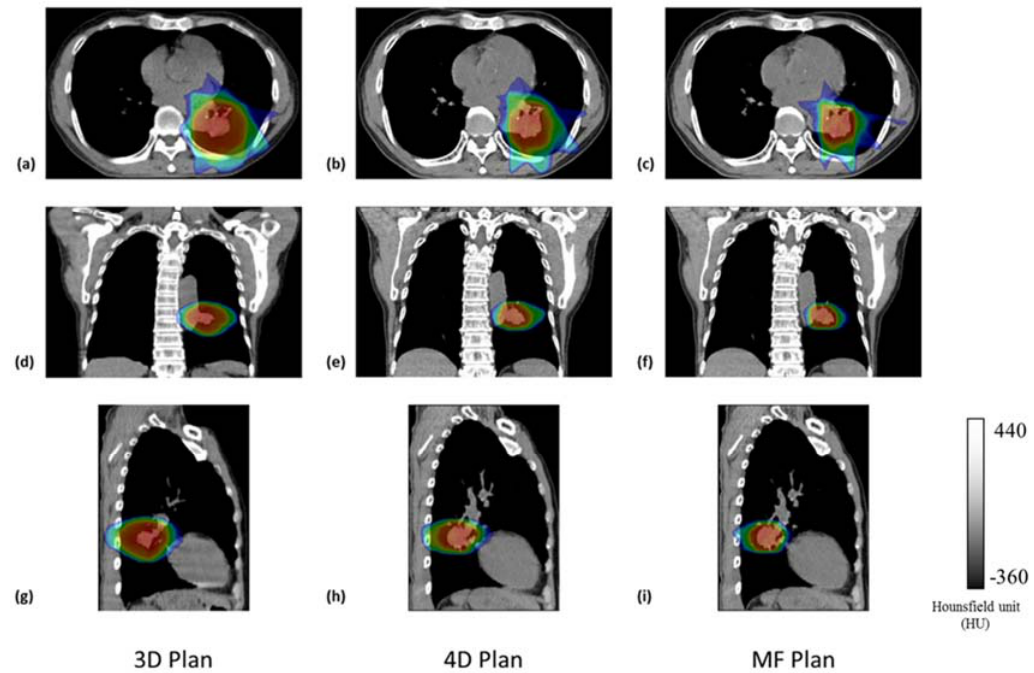
Figure 3. Radiation dose distribution of ( a – c ) transverse, ( d – f ) coronal, and ( g – i ) sagittal sections of the chest computed tomography (CT) image. The dose distributions shown here are for the 3D Plan ( a , d , g ), 4D Plan ( b , e , h ), and MF Plan ( c , f , i ).